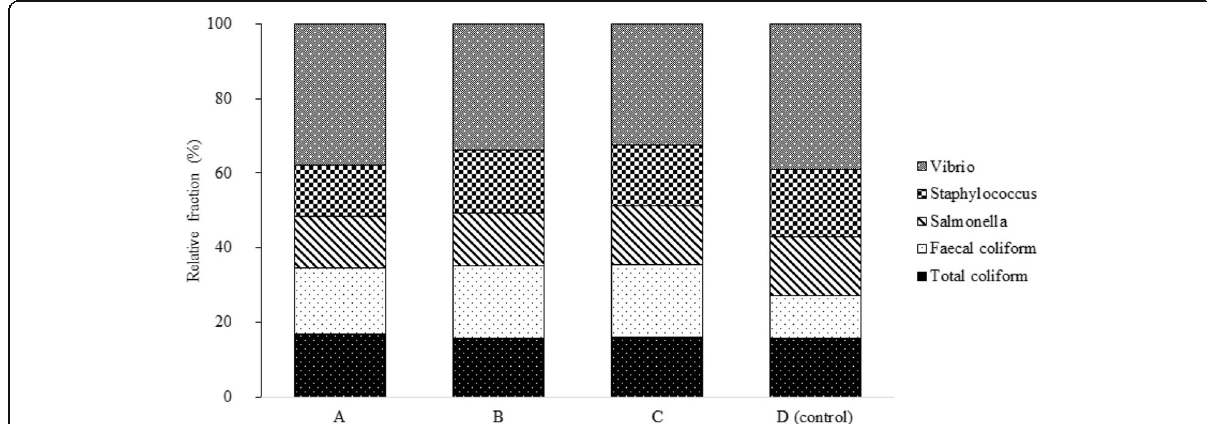
Fig. 3 Percentage relative fractions of potential pathogens and indicator bacteria during anaerobic digestion. A, B, C indicate manure supplemented reactors, while D =